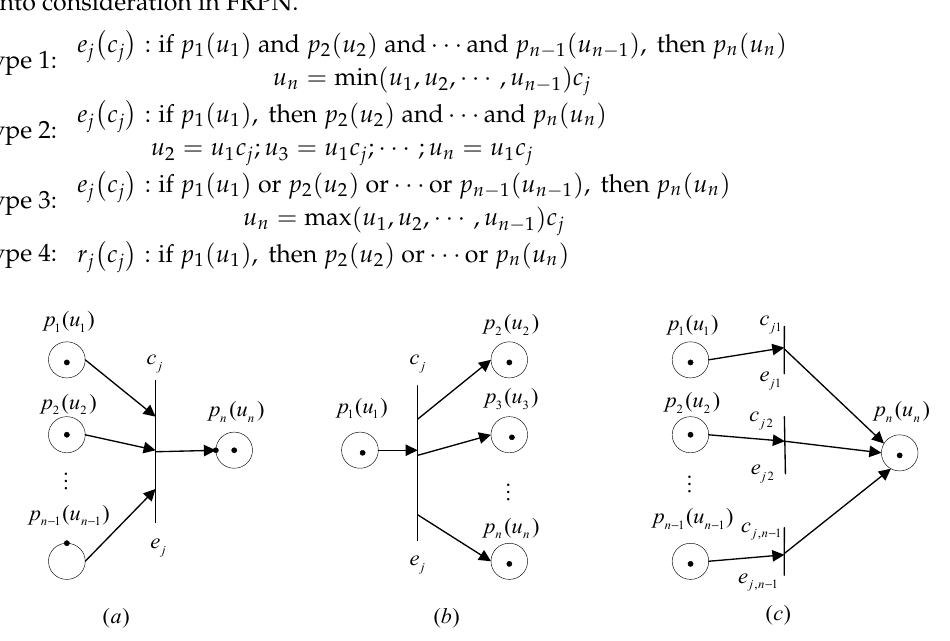
Figure 2. Compound fuzzy production rules with fuzzy PN: ( a ) FRPN of types 1; ( b ) FRPN of types 1; ( c ) FRPN of types 1 .